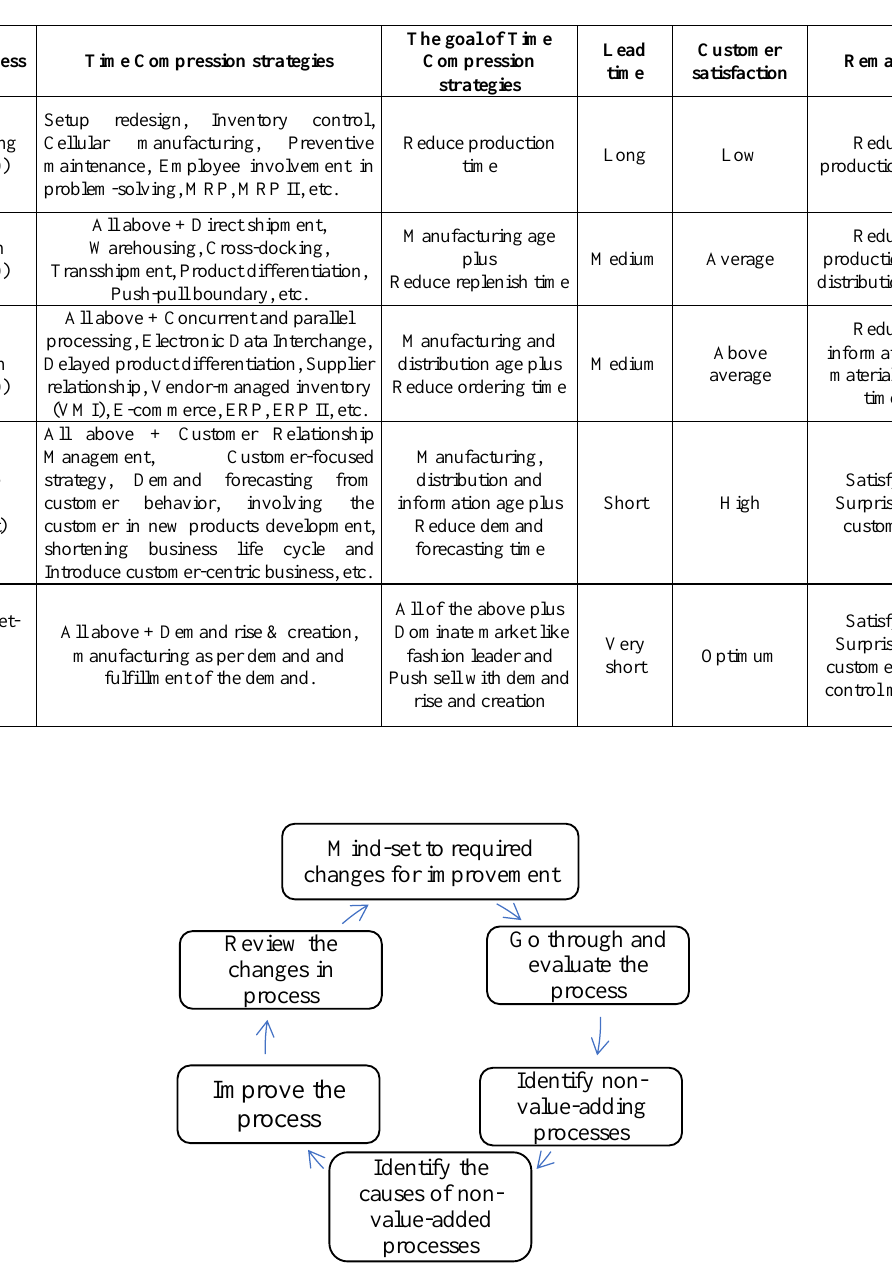
Table 1. Lead time reduction strategies depending on their age (Simchi-Levi et al., 2008)